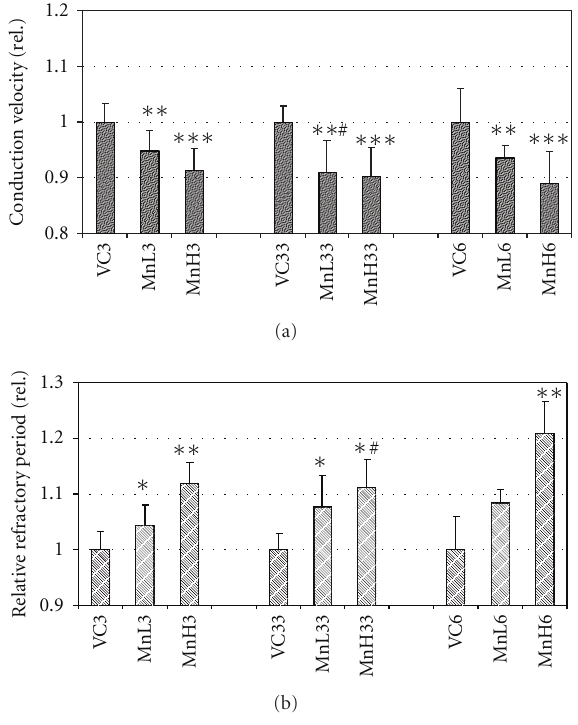
Figure 4: Changes of the nerve conduction velocity (a) and relative refractory period (b) in the tail nerve of the rats. Mean + SD, n = 8. The relative data were calculated as given at Figure 2. ∗ , ∗∗ , ∗∗∗ : P < 0 . 05, 0.01, 0.001 treated versus VC; # : P < 0 . 05, 0.01 MnL33 versus